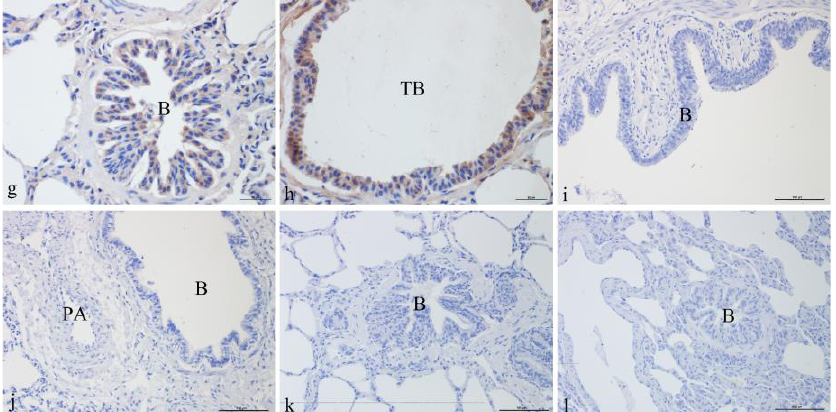
Figure 2. ATP6V0D2 localization in yak lungs at different ages. ( a , b ). Bronchioles of yak lungs in the newborn group (400 × ). ( c ) Bronchioles of yak lungs in the juvenile group (400 × ). ( d ) Small bronchi in the juvenile group (100 × ). ( e ) Bronchioles of yak lungs in the adult group (100 × ). ( f ) Bronchioles of yak lungs in the adult group (400 × ). ( g ) Bronchioles of yak lungs in the elderly group (400 × ). ( h ) Terminal bronchioles of yak lungs in the elderly group (400 × ). ( i ) Blank control of bronchioles of yak lungs in the newborn group (200 × ). ( j ) Blank control of bronchioles of yak lungs in the juvenile group (200 × ). ( k ) Blank control of bronchioles of yak lungs in the adult group (200 × ). ( l ) Blank control of bronchioles of yak lungs in the elderly group (200 × ). SB—small bronchi; B—bronchiole; TB—terminal bronchiole.